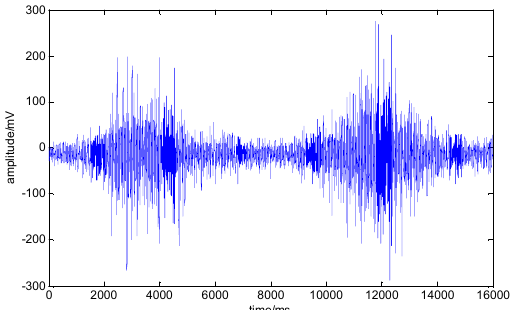
Figure 10. The original surface electromyography (sEMG) signal of the vastus medialis (VM). The abscissa is the number of signal points, and the ordinate is the signal